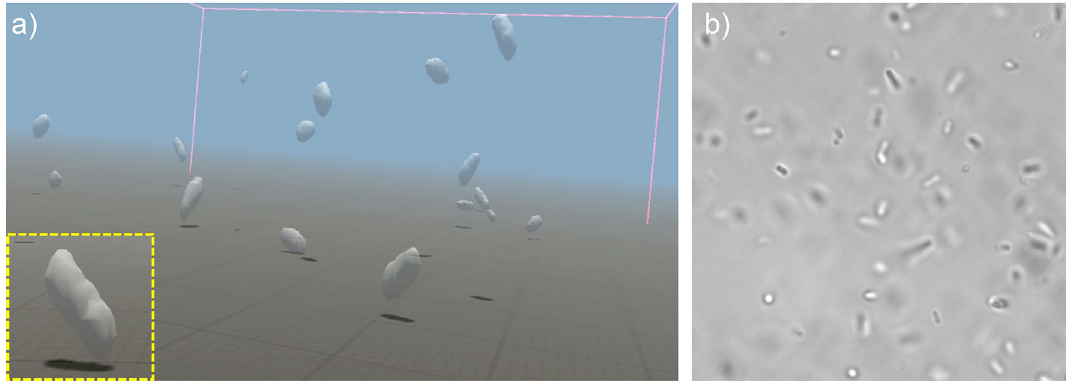
Figure 6. ( a ) Real time mesh rendering of swimming E. coli bacteria. The reconstructed volumetric density in the entire field of view is segmented by an isosurface. A close view of an individual cell is shown in the highlighted square panel. (see also Supplementary Video 4). ( b ) For comparison we show a bright field microscopy image of the same bacteria. This figure was made using Unity 28